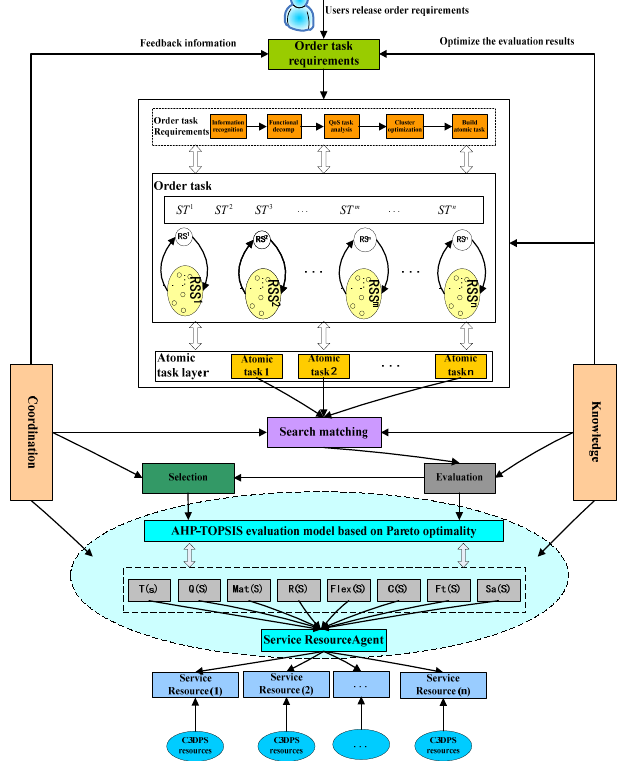
Figure 1. Framework of the evaluation method of the C3DPS order task execution process based on the AHP-TOPSIS optimal set algorithm and Baldwin effect.